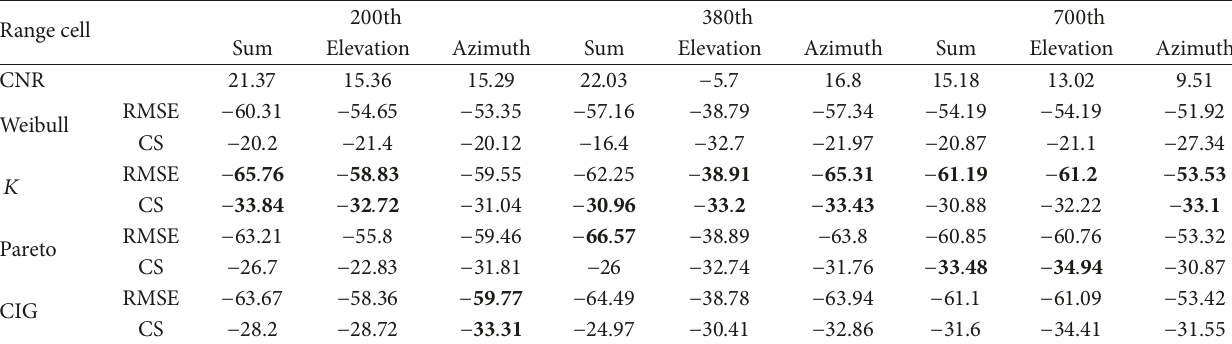
Table 6: RMSE and CS test of the different theoretical PDFs for DS2 (in